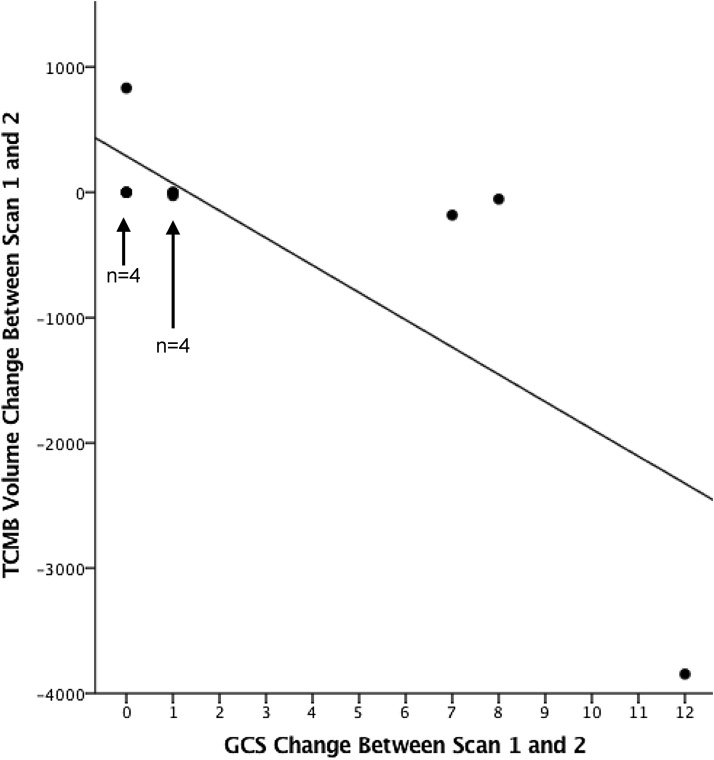
Relationship between change in GCS from presentation to second scan and change in total lesion volume between scan 1 and scan 2.Figure 4 Legend. Graphical representation of the relationship between change in GCS from presentation to the second scan and change in total lesion volume between scan 1 and scan 2. Patients who experienced the most marked improvement in GCS had the greatest reduction in total lesion volume between the two scans. There was a negative correlation between GCS change and total SWI lesion volume change (R = −0.718, p = 0.009). Data points for patients with no change, or very little change, in lesion volume are represented by over-lapping data points due to an equivalent change in lesion volume value.